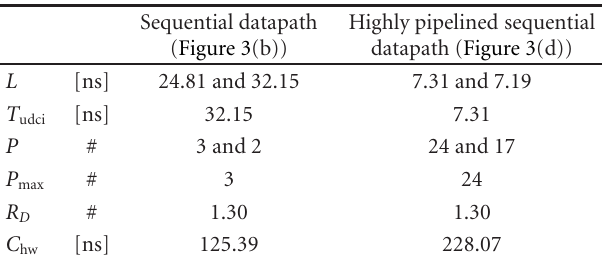
Table 3: Results of hardware estimationprocess for DFGs presented in Figures 3(b) and 3(d) implemented with two di ff erent sets of operators found in Table